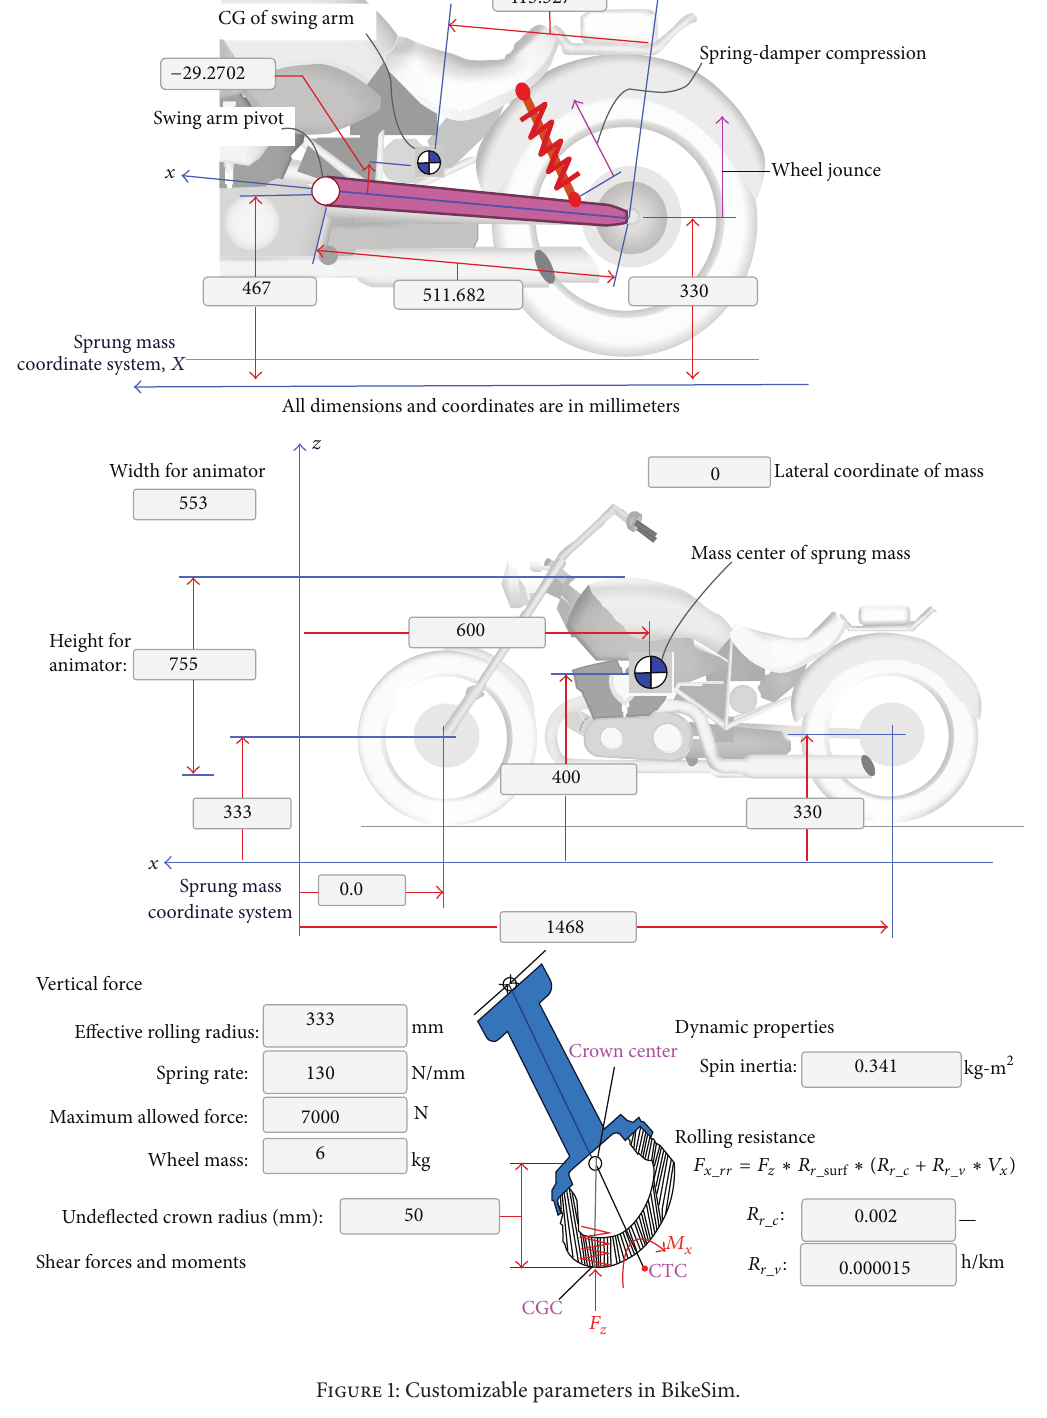
Figure 1: Customizable parameters in